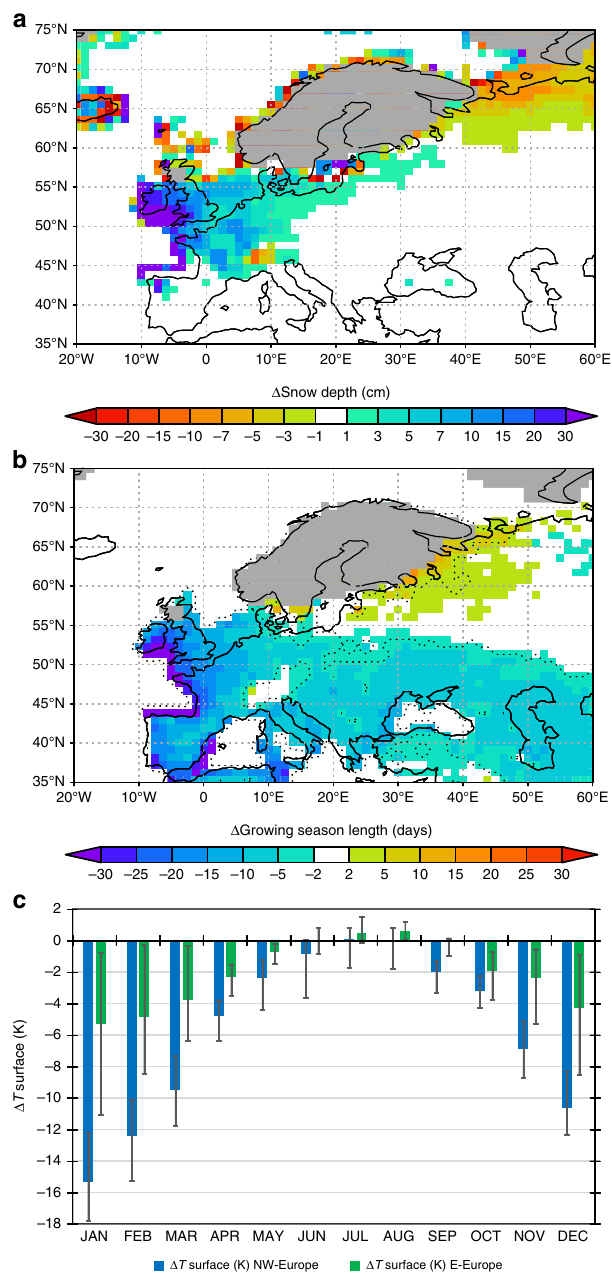
Fig. 4 Simulated seasonality changes during the YD relative to BA. a Changes in snow depth (cm) in May; b changes in GSL (days) and c changes in the annual cycle of monthly mean surface temperatures averaged over NW-Europe (blue) and E-Europe (green) (K). Error bars in c represent the 90% spatial temperature spread around the regional